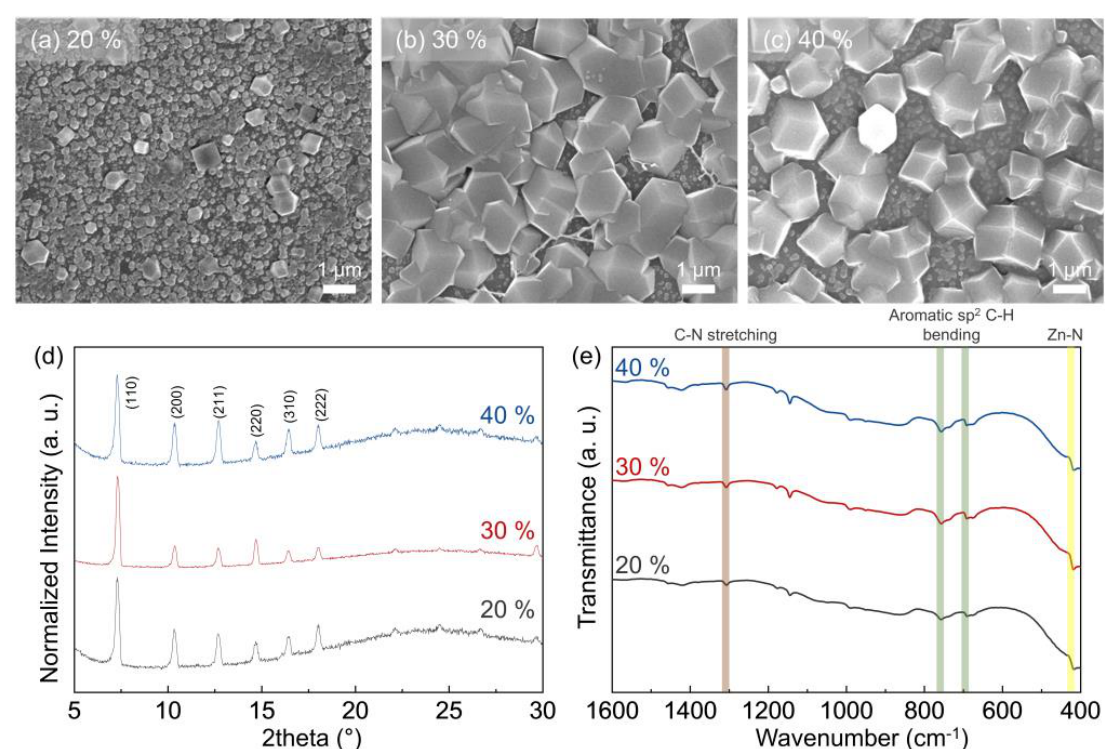
Figure 2. ( a – c ) SEM images (( a ): 20%, ( b ): 30%, and ( c ): 40%), ( d ) XRD patterns, and ( e ) FT-IR spectra for the ZIF-8 grown on the substrates depending on relative humidity (20, 30, and 40%) at chamber temperature of 60 °C.